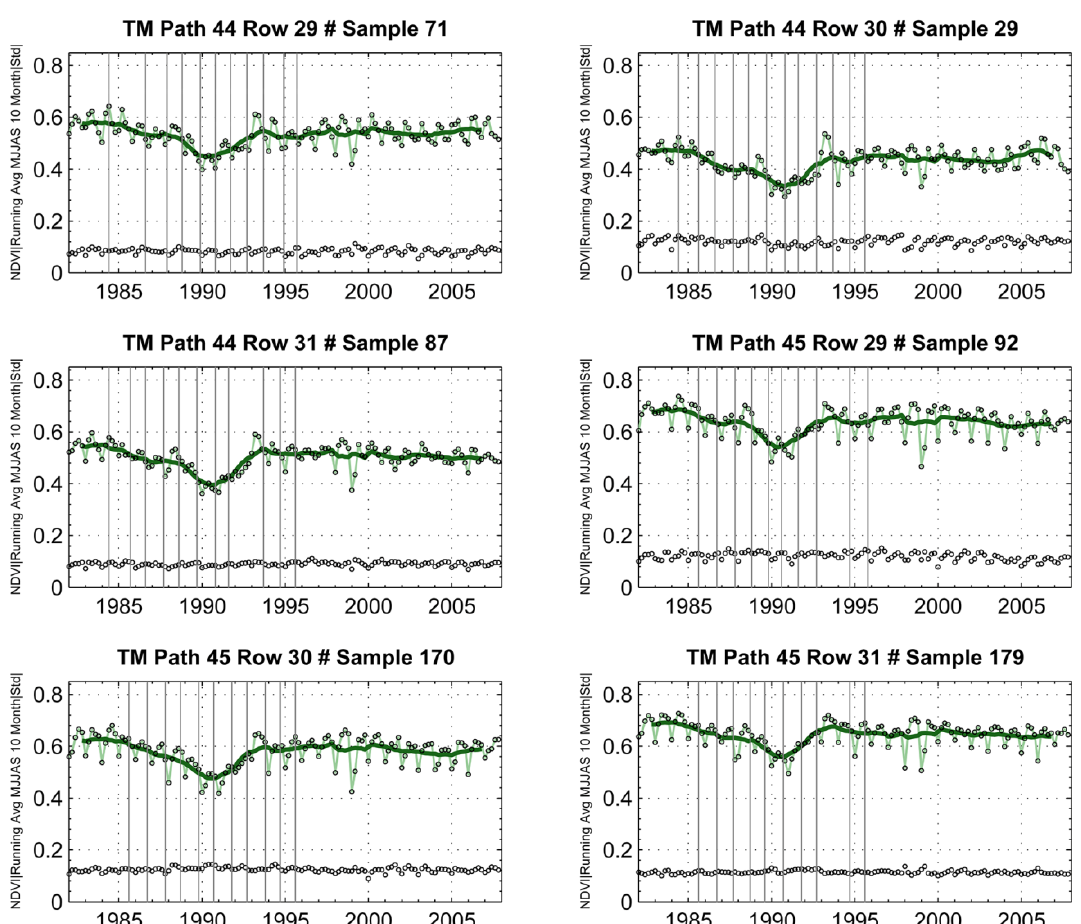
Figure 4. AVHRR NDVI time series for six path/rows with a mean of negative trends less than −0 .05 indicted with green circles for growing season months May to September and the solid green line indicating the three-year running average. The number of AVHRR sampled pixels meeting the criteria is indicated by the title for each path row. Vertical grey lines indicate image dates, and the bimonthly standard deviation is shown in black